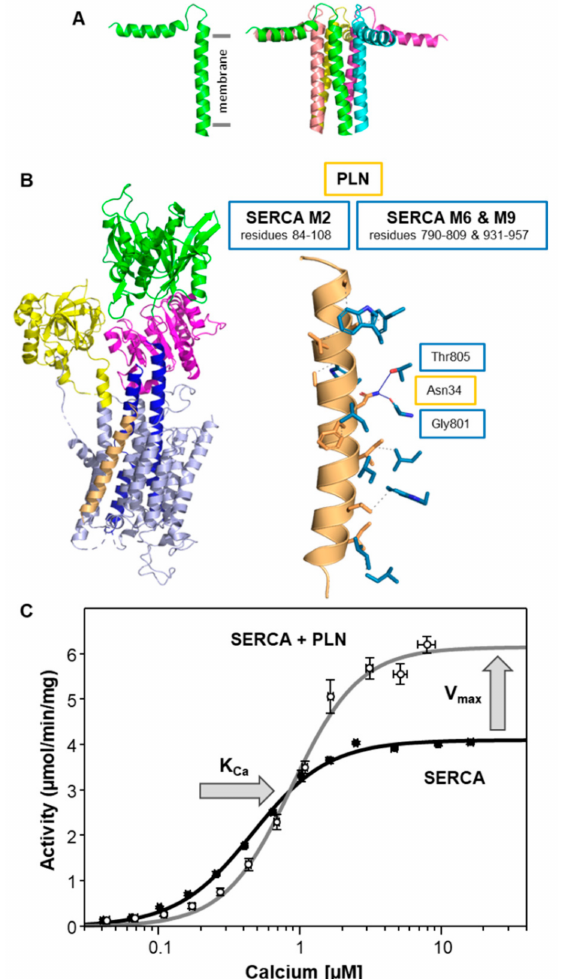
Figure 2. SERCA and phospholamban (PLN). ( A ) Molecular model of the PLN monomer and pentamer (PDB code 2KYV). The transmembrane domain is indicated. ( B ) Molecular model of the SERCA-PLN complex (PDB code 4KYT). PLN is colored tan (chain B; chain C is not shown). SERCA is colored light blue with the actuator domain in yellow, the phosphorylation domain in magenta, the nucleotide-binding domain in green, and transmembrane segments M4 and M5 in blue. Also shown are the side-chain interactions between SERCA (blue) and PLN (tan). The relative locations of SERCA transmembrane segments M2, M6, and M9 are indicated. An essential interaction involving Asn 34 of PLN and Thr 805 and Gly 801 of SERCA is shown. For the full list of interactions, refer to Table S1. ( C ) Calcium-dependent ATPase activity of SERCA reconstituted into membrane vesicles in the absence (black) and presence of PLN (gray). The changes in the apparent calcium affinity (K Ca ) and maximal activity (V max ) of SERCA are indicated by arrows. Each data point is the mean ± standard error ( n ≥